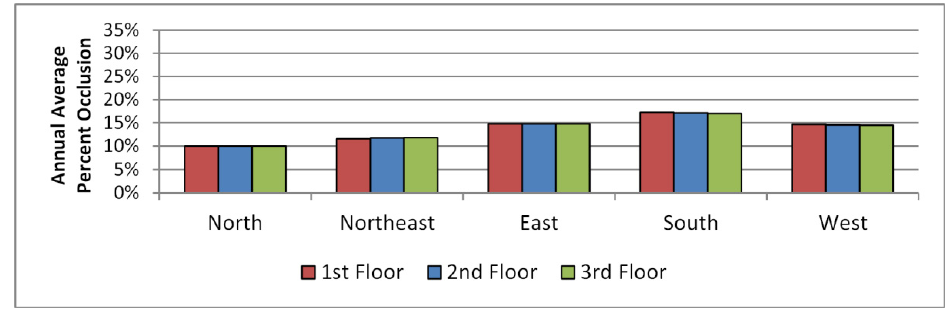
Figure 16. Annual average percent occlusion (Blindswitch B).